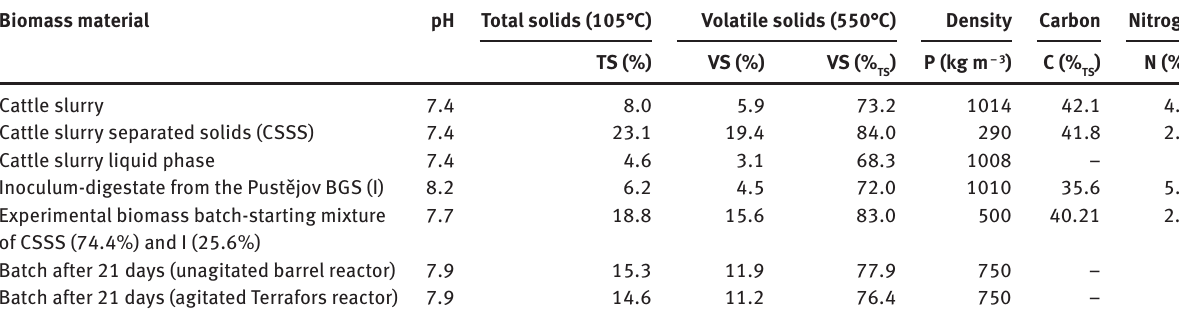
Table 1: Biomass